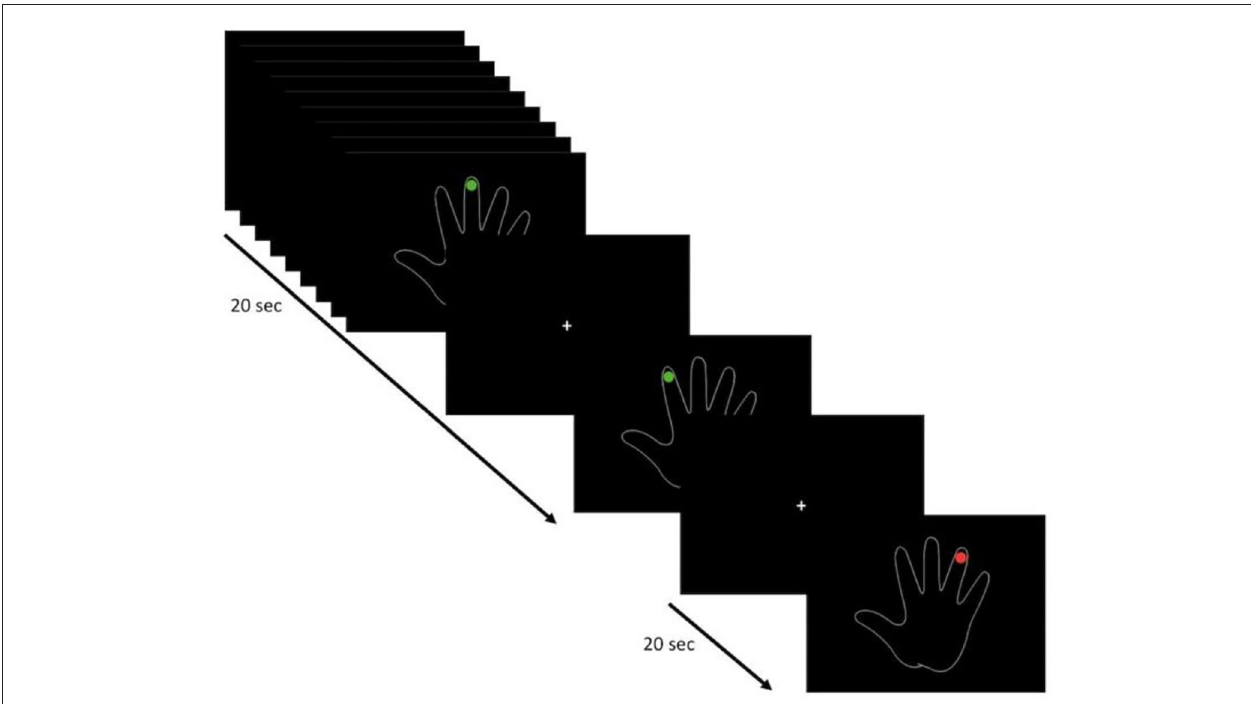
FIGURE 1 | Visual-triggered finger movement task (VFMT) protocol (e.g., right hand). Active condition (green dot): patients are instructed to move the corresponding finger when a green dot appears. Passive condition (red dot): patients are instructed to observe without making any